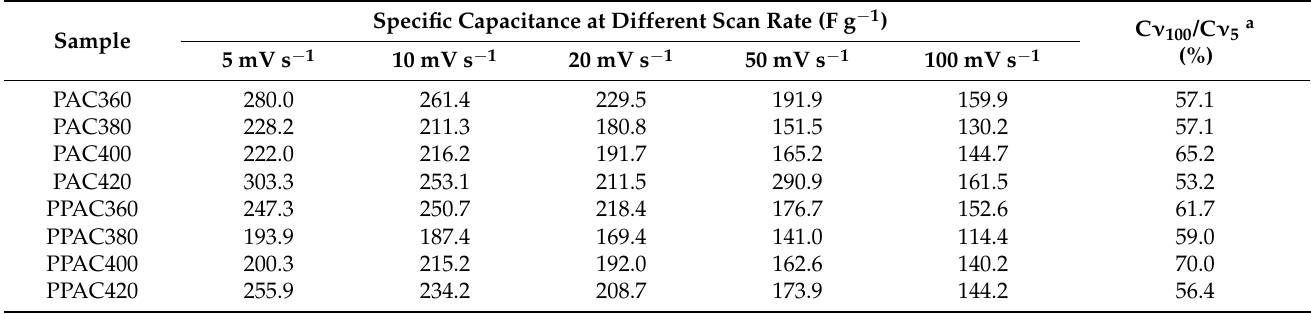
Table 1. Various specific capacitance at different scan rates from 5 mV s − 1 to 100 mV s − 1 . Sample